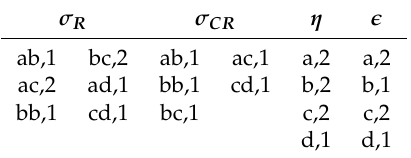
Table 3. Output Reducer MR-I